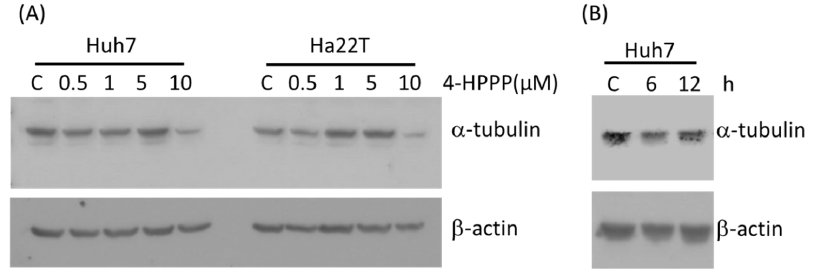
Figure 4. The effect of 4-HPPP on tubulin expression of HCC cells. ( A ) Expression of α -tubulin protein in HCC cells Huh7 and Ha22T cells treated with indicated concentrations of 4-HPPP. ( B ) Expression of α -tubulin in Huh7 cells treated with 10 µ M of 4-HPPP for 6 and 12 h respectively. The results of Western blot analyses of α -tubulin were from representative samples. β -actin as an internal control. C stands for vehicle control.